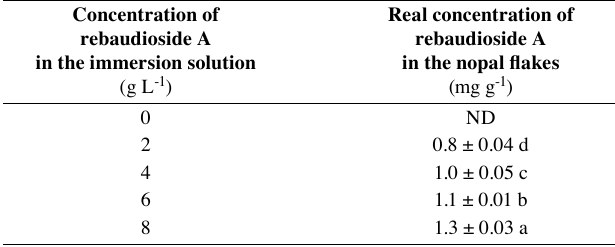
Values represent the mean ± standard deviation of 3 replicates. Different letters in the same column indicate statistically signifi cant difference by Tukey’s test (p < 0.05). Abbreviations: ND = not detected.